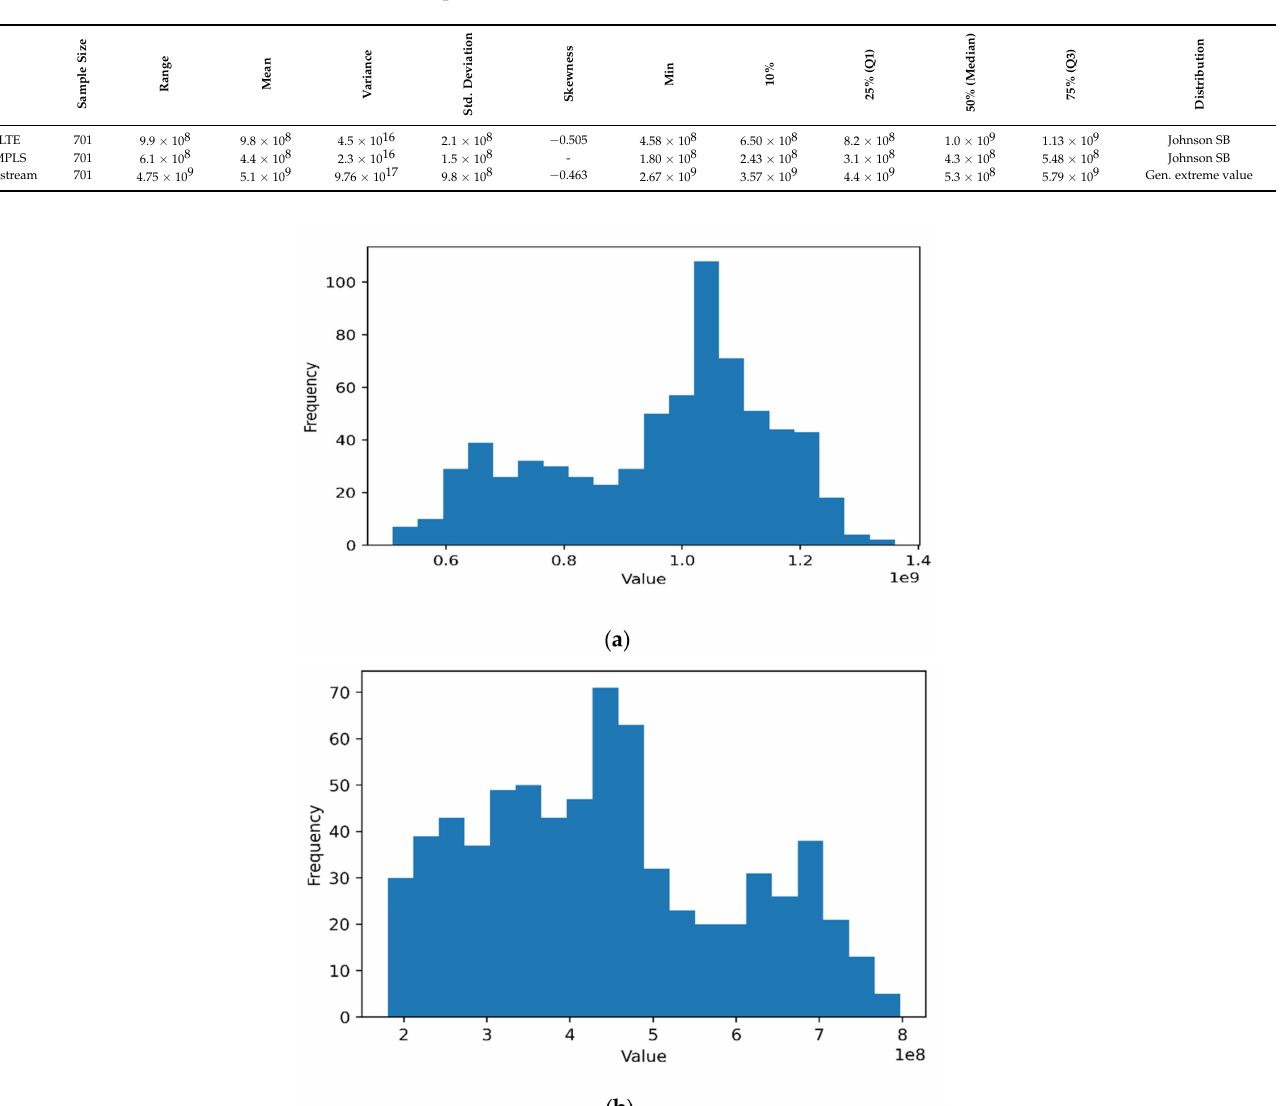
Table 3. Descriptive statistics.